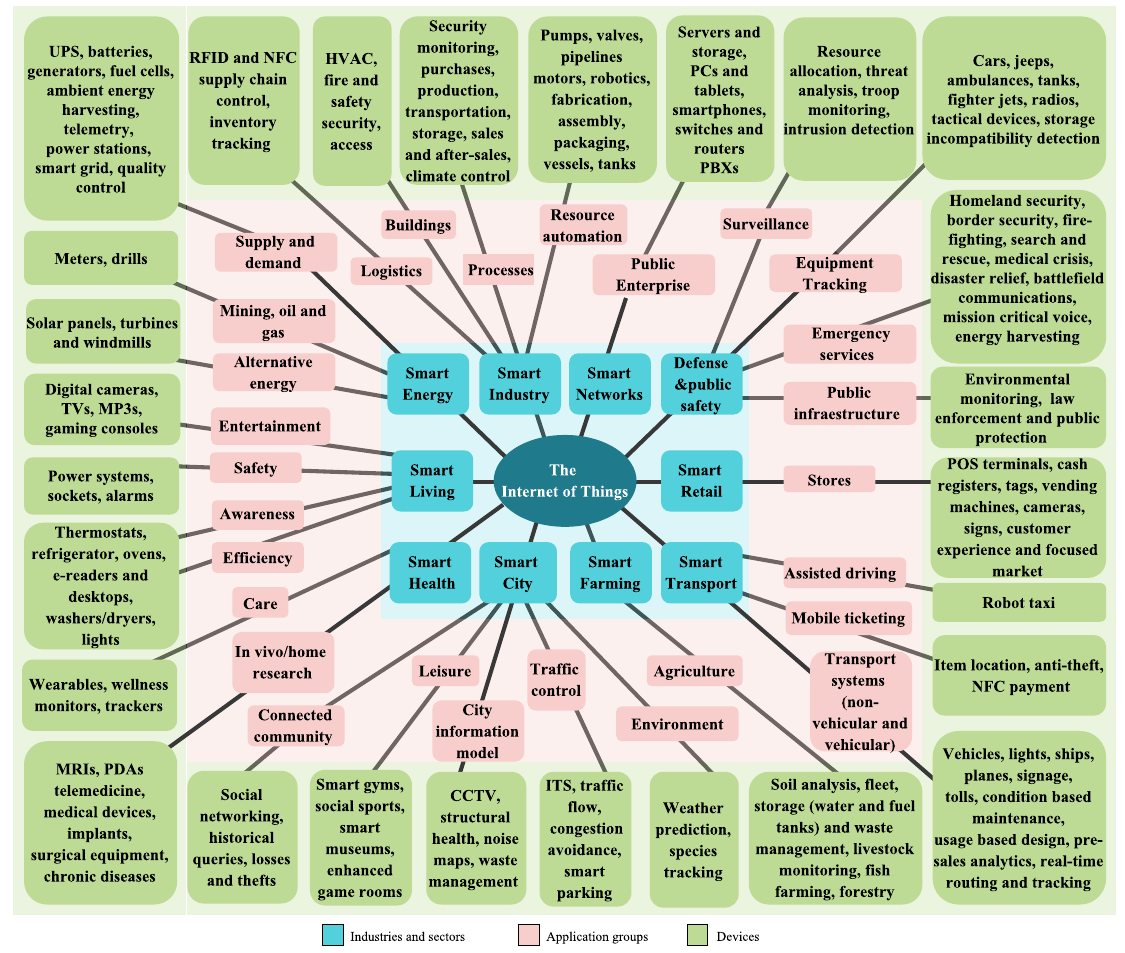
Figure 1. Proliferation of devices and applications in the Internet of Things